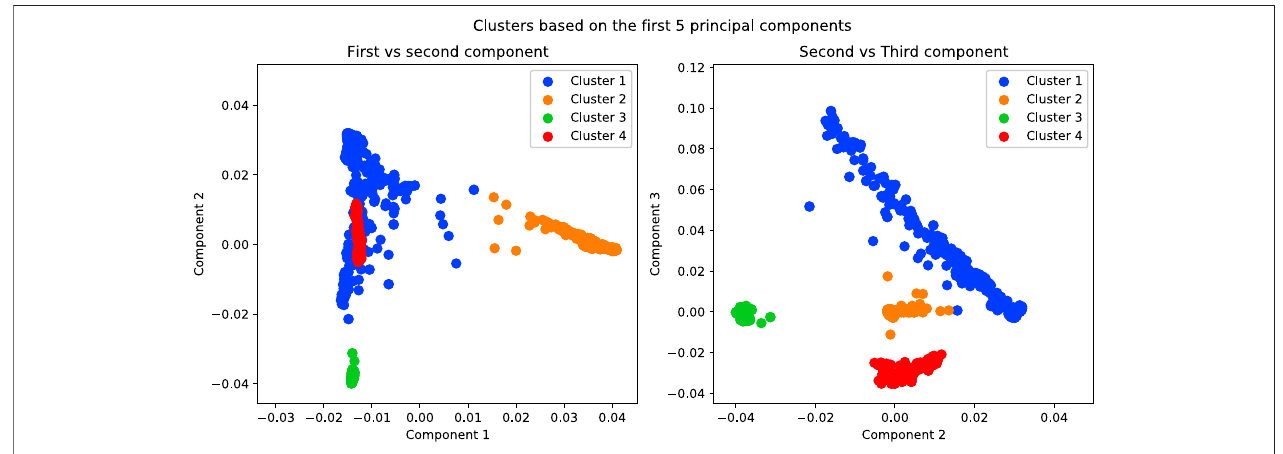
FIGURE7| Results ofrunning aK-Means algorithmon the fi rst 5 components of thesimulated data withK (cid:1) 4. The purpose ofthisanalysisistoseparatethe data into subpopulations in order to conduct association tests within each.